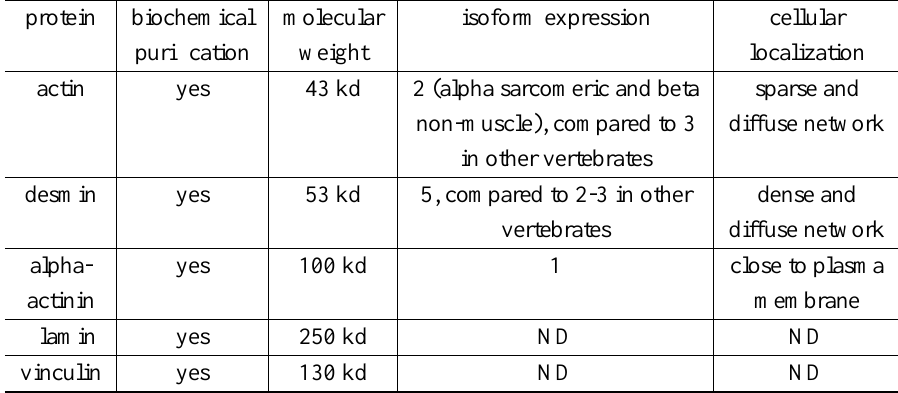
Comparison between the biochemical purification, molecular weight, isoform expression and cellular localization of five cytoskeletal proteins from the electric organs of E. electricus. ND = not